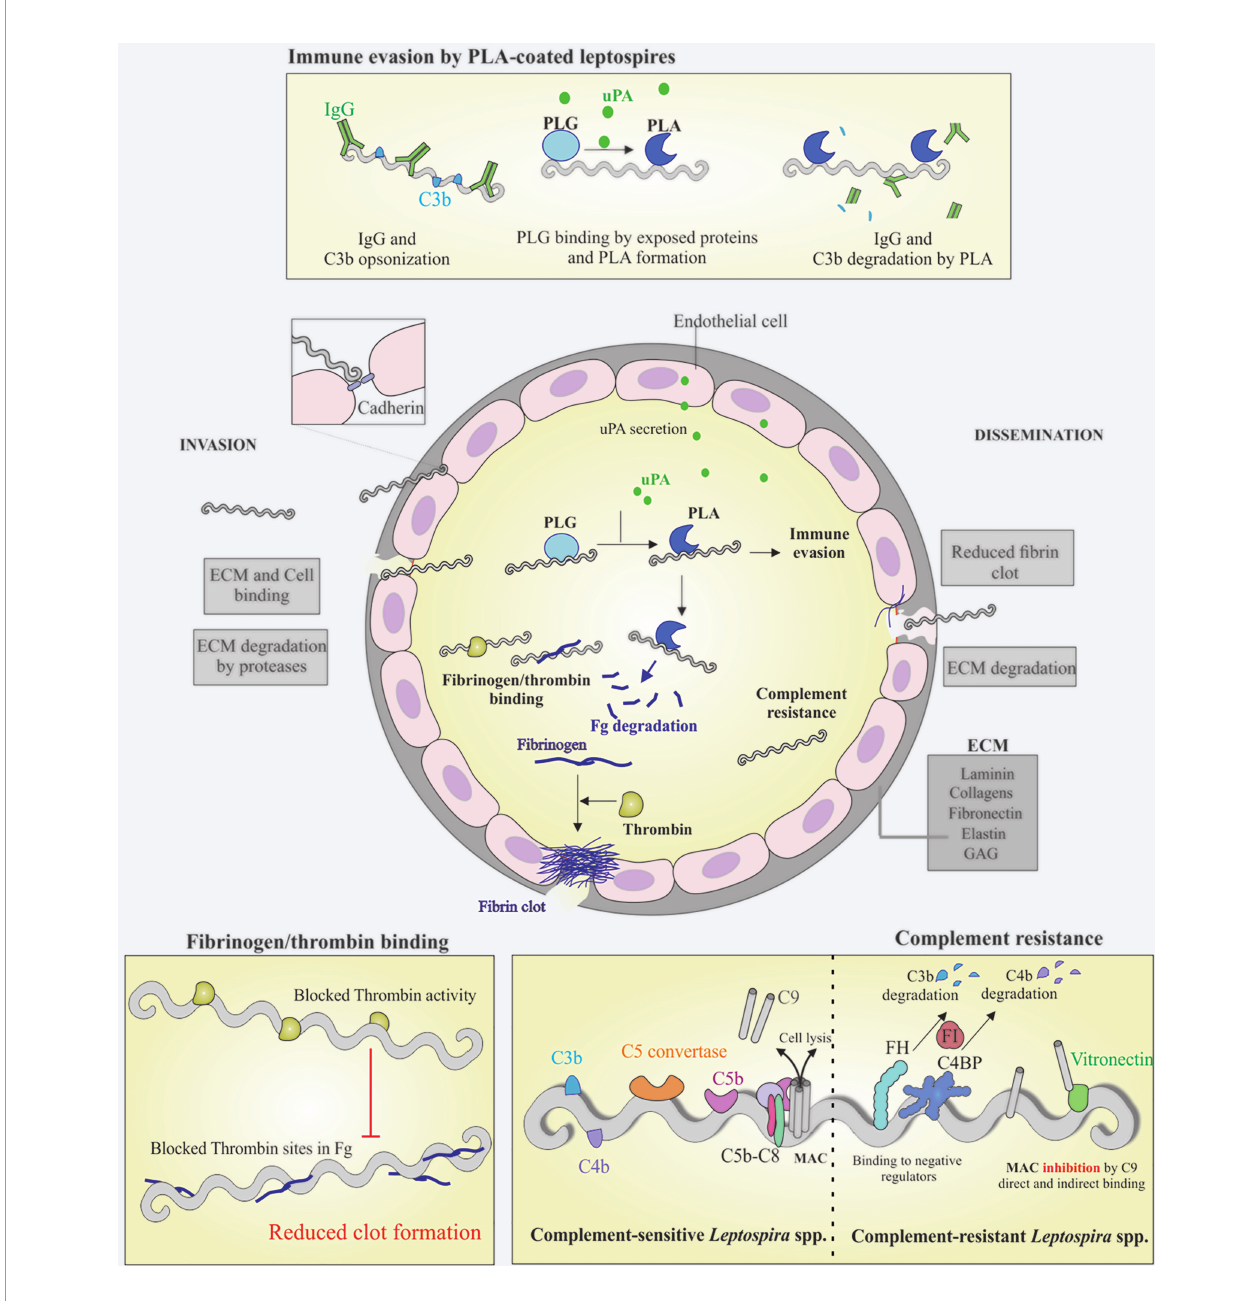
FIGURE 1 | Schematic view of colonization, invasion and evasion mechanisms displayed by pathogenic Leptospira . Leptospires can penetrate the host via breached skin or intact mucosa, taking advantage of many surface exposed proteins that are able to interact with a broad range of host components, including the extracellular matrix (ECM) components and glycosaminoglycans (GAGs). During the invasion process, leptospires can directly bind to ECM components and cell receptors, as cadherins, the latter favoring cell-cell integrity disruption (center). Leptospires interact with host plasminogen (PLG) (top and center) and induce the endothelial secretion of urokinase-type PLG activator (uPA), which in turn converts leptospires-bound PLG to its active form, plasmin (PLA). The latter, a broad- spectrum serine protease, is capable of degrading ECM components and immune mediators, as IgG and C3b, reducing opsonophagocytosis (top). One of the host mechanisms to block pathogen dissemination to other sites after endothelial lesion is the formation of fi brin clot, as a result of fi brinogen (Fg) cleavage by thrombin. In addition to Fg degradation by PLA, pathogenic Leptospira can also bind both Fg and thrombin, causing a bilateral obstruction of the fi brin clot reaction, favoring the dissemination step (left bottom), in association with ECM degradation by endogenous proteases and surface-associated PLA (center). Once in the bloodstream, leptospires must overcome one of the fi rst lines of host defense, the complement, and this is achieved by a multitude of mechanisms, including binding to the negative complement regulators Factor H (FH) and C4 binding protein (C4BP), which participate in the degradation of C3b and C4b, respectively. Binding to terminal components C7, C8, C9 and vitronectin, would decrease membrane attack complex (MAC) formation (right bottom). Taken together, it is anticipated that these mechanisms will facilitate invasion and dissemination of Leptospira through the